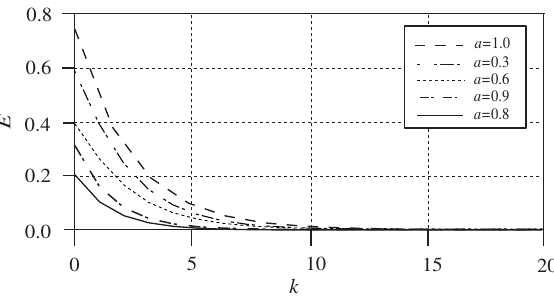
Figure 8. The iterative number-max tracking error with different α